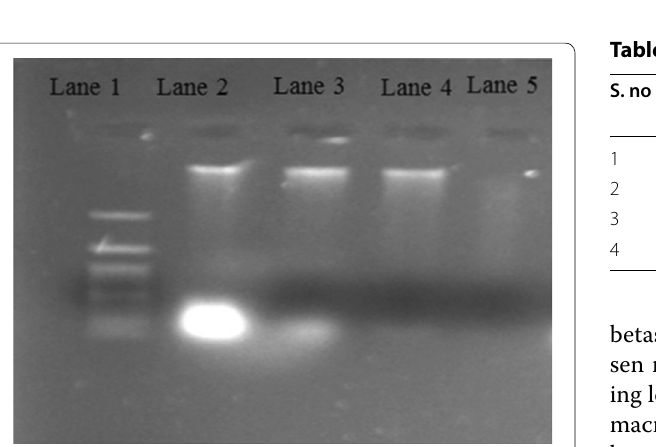
Fig. 5 Apoptotic DNA fragmentation was observable in Syzygium cumini methanolic seed extract treated Bacillus subtilis MTCC2413 Lane 1—DNA ladder, lane 2—untreated genomic DNA (control) of Bacillus subtilis MTCC2413, lane 3—treated Bacillus subtilis MTCC 2413 DNA for 24 h, lane 4—treated Bacillus subtilis DNA MTCC 2413 DNA for 48 h, lane 5—treated Bacillus subtilis MTCC 2413 DNA for 72 h